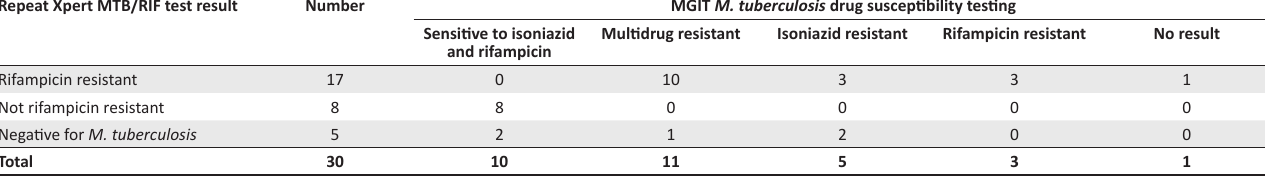
TABLE 3: Comparison of repeat Xpert MTB/RIF and mycobacterium growth indicator tube Mycobacterium tuberculosis drug susceptibility testing. Repeat Xpert MTB/RIF test result